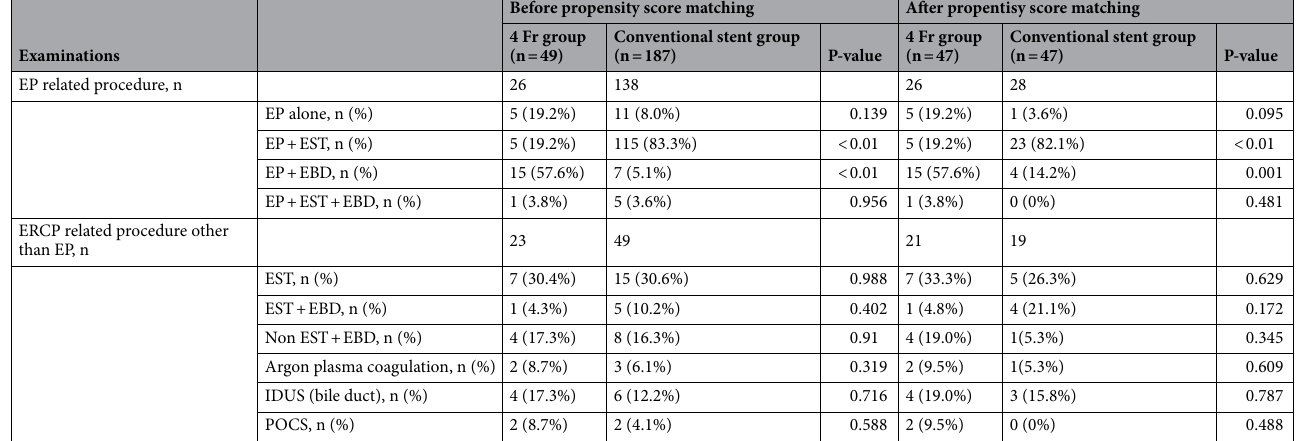
Table 2. Examination details of study populations. EP, endoscopic papillectomy; EST, endoscopic sphincterotomy; EBD, endoscopic biliary drainage; IDUS, intraductal ultrasonography; POCS, peroral cholangioscopy.